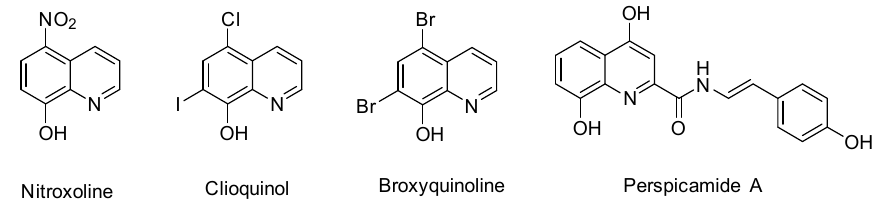
Figure 1. Bioactive 8-hydroxyquinoline derivatives.